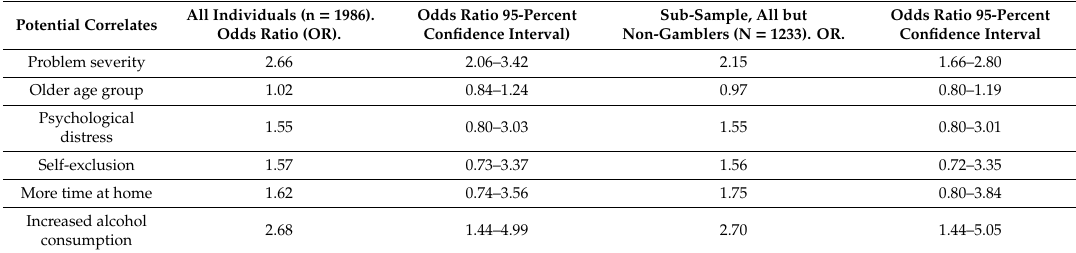
Table 3. Logistic regression analyses examining correlates of reporting an increase in overall gambling, in all individuals with full data for all included variables (n = 1986), and for the sub-group including respondents who report no gambling neither during the COVID-19 crisis nor prior to it (n = 1233). Binary, non-stepwise regression analyses including all variables associated with gambling increase in bivariate analyses.